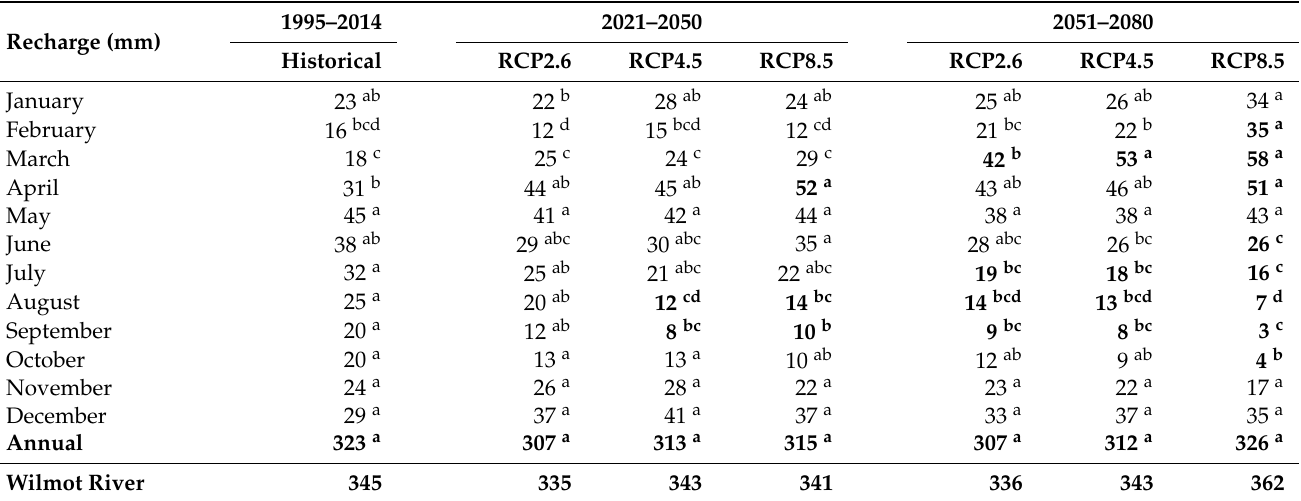
Table 15. Average recharge (mm) in the western zone (Mill and Wilmot River watersheds)